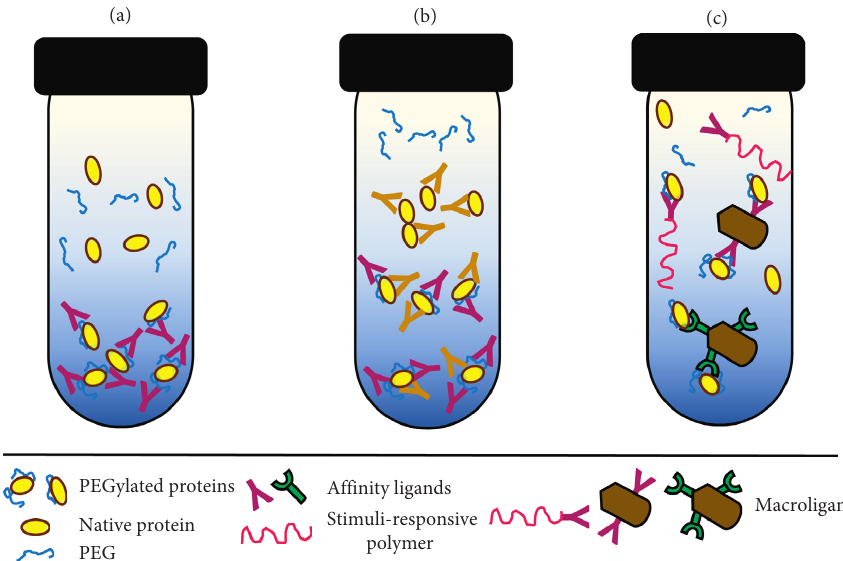
Figure 2: Proposed designs for the affinity precipitation of PEGylated